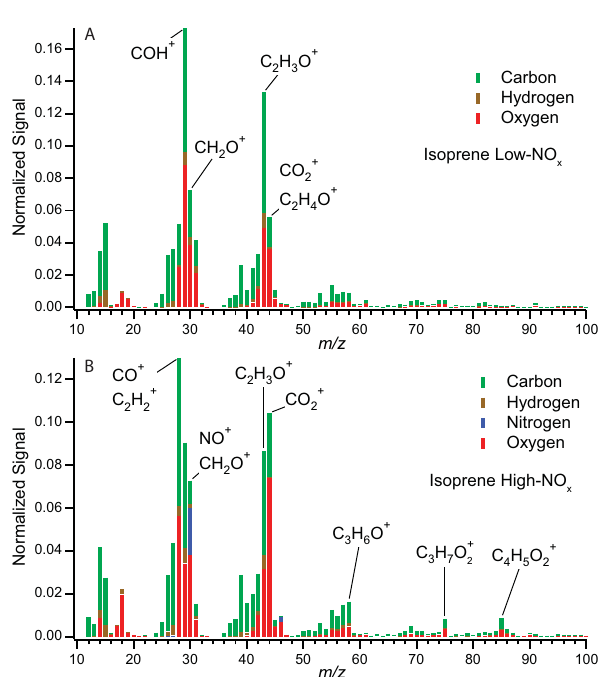
Fig. 5. High-resolution mass spectra of isoprene SOA formed under low-NO x (A) and high-NO x (B) conditions with elemental contri- butions to each mass-to-charge ratio shown. Spectra are taken at the peak of SOA growth.